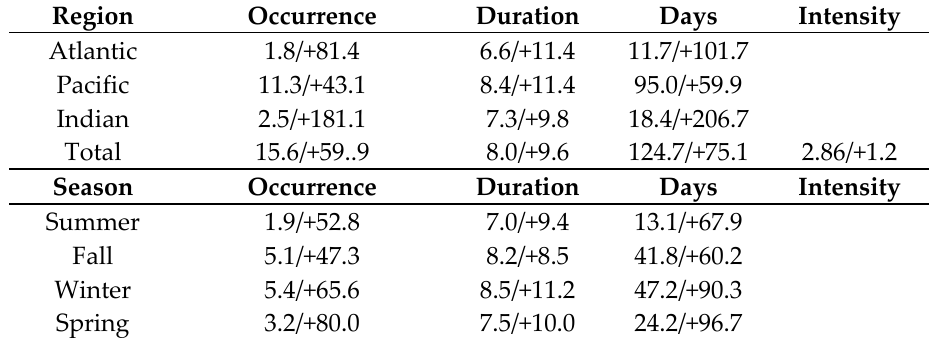
Table 3. Character of Southern Hemisphere blocking events per year as a function of region and season for all characteristics since the study of [1]. The change in the value is expressed as a